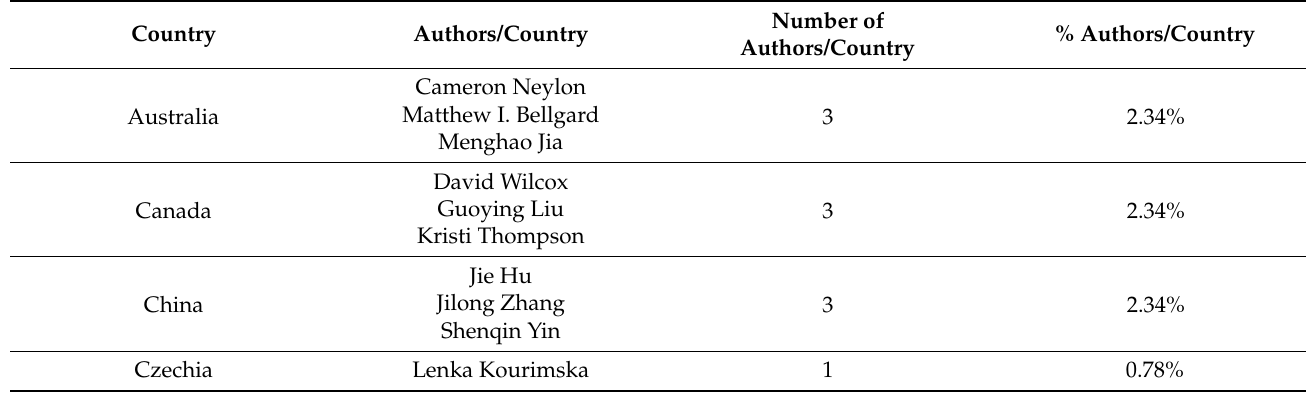
Table A2. Distribution of authors by